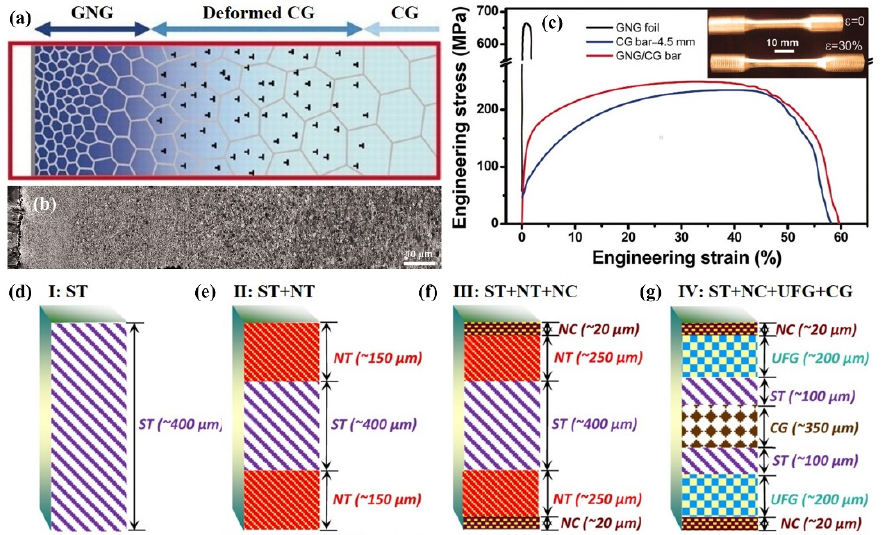
Figure 9. ( a ) Schematic of the cross-sectional microstructure of GNG Cu (CG refers to the coarse grain), where the solid symbols represent dislocation tangles or dislocation cell [136]; ( b ) a cross-sectional SEM image of an SMGT Cu sample [136]; ( c ) the tensile engineering stress–strain curves for the CG Cu, GNG Cu, and a freestanding GNG foil sample, and inset shows the tensile GNG Cu sample before and after tension [136]; schematic images of four types of gradient-structured 304 SS [143] (ST, NT, NC, UFG), and CG refers to sub-micrometer twins, nanotwins, nanocrystalline, ultrafine grains, and coarse grains, respectively); ( d ) ST; ( e ) ST + NT; ( f ) ST + NT + NC; ( g ) ST + NC + UFG + CG.